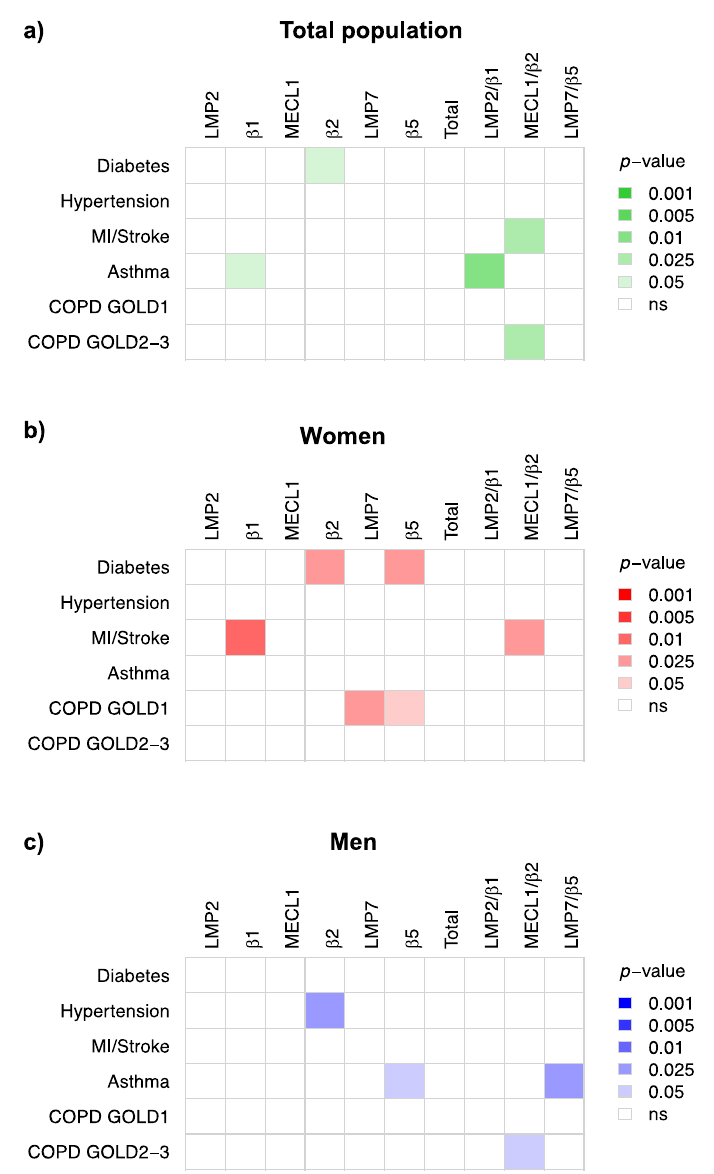
Figure 5. Differential regulation of proteasome activities in chronic inflammatory diseases. Multiple linear regression models for the association between diabetes, hypertension, myocardial infarction and/or stroke, asthma and COPD with log2 transformed proteasome parameters, additionally adjusted for sex, age, BMI, smoking status, and leukocyte cell count were calculated. The p -values resulting from the regression models based on the total study population ( a ) as well as separately for women ( b ) and men ( c ) are displayed. p -values above 0.05, indicating non-significant associations, are displayed in white color whereas significant associations are displayed in green, red or blue color, respectively. The color intensity increases with decreasing p